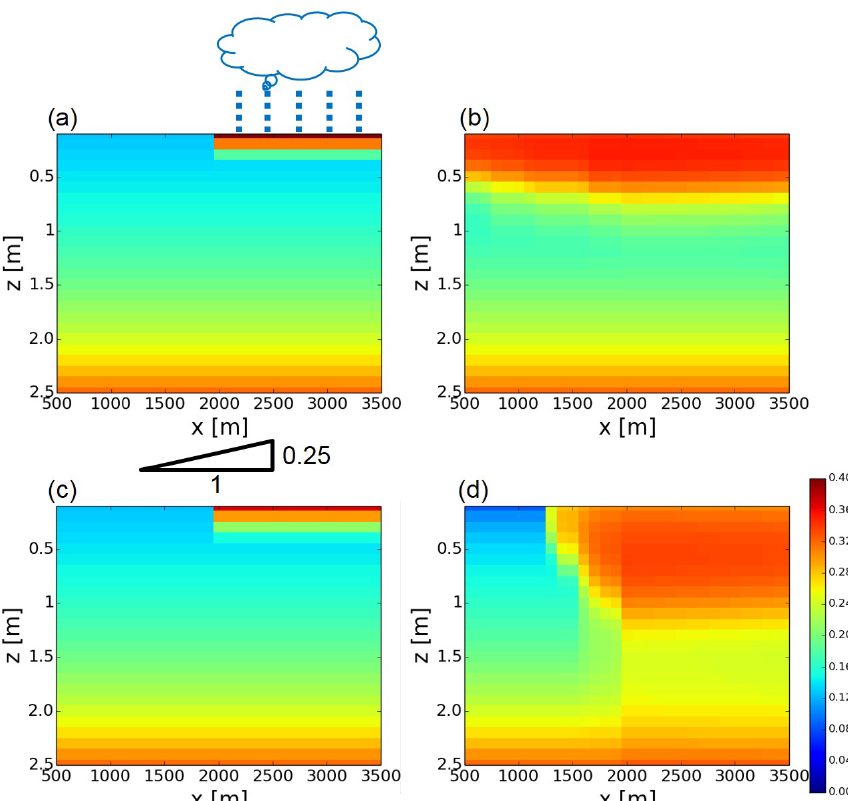
Figure 1. Distributions of volumetric soil moisture simulated by the synthetic reference runs. (a) The distribution of volumetric soil moisture (m 3 m − 3 ) simulated by the LOW_K synthetic reference run at t = 0h. The schematic of the configuration of the synthetic reference runs is also shown (see also Sect. 3). (b) Same as (a) but at t = 130h. (c, d) Same as (a, b) but for the HIGH_K synthetic reference run.